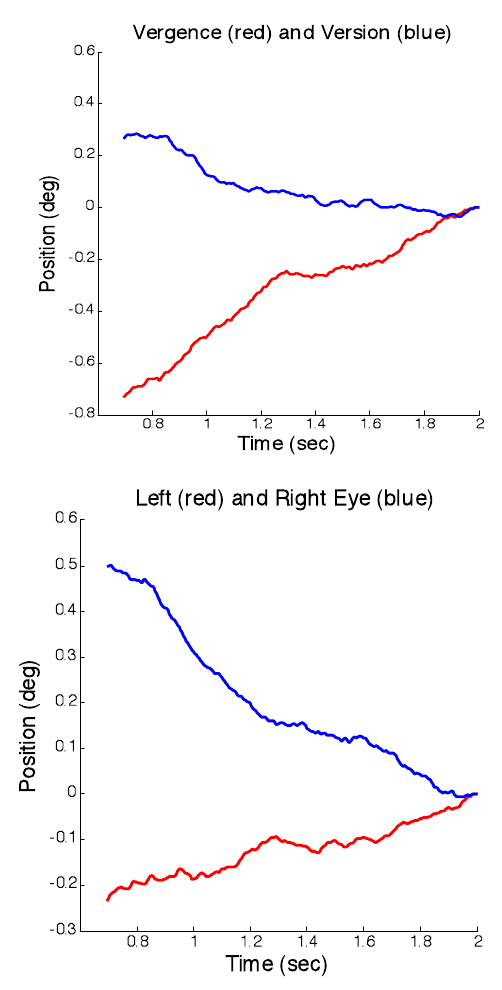
Figure 3 The fusion sustaining late portion of an individual response to a pure disparity vergence step stimulus plotted a version and vergence (upper plot) and as the actually recorded left and eye movements(lower